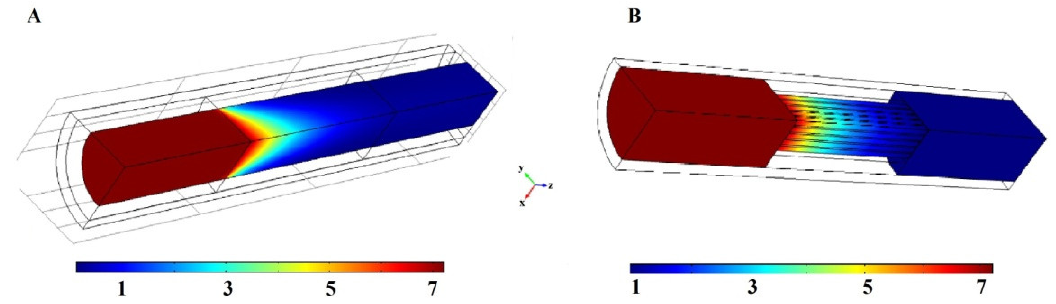
Figure 9. CO concentration (mol/m 3 ) in the 3D simulation domain: PtCeWF10 ( A ) and PtCeWM ( B ).